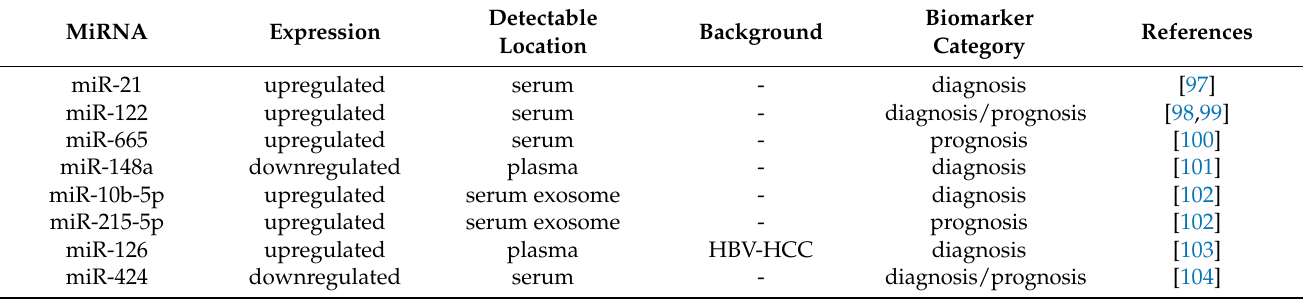
Table 3. Recent studies on the expression levels of potential circulating miRNA biomarkers in hepatocellular carcinoma.